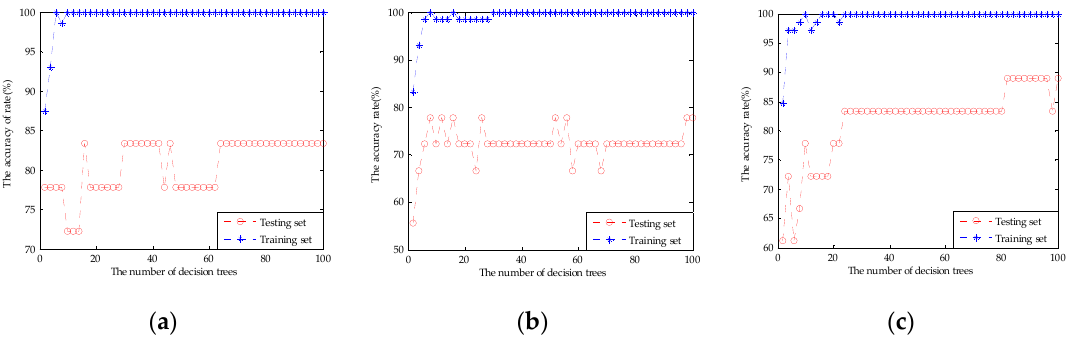
Figure 10. The classification performance of the RF based on the number of decision trees: ( a ) e-tongue; ( b ) e-nose; and ( c ) the original fusion set.